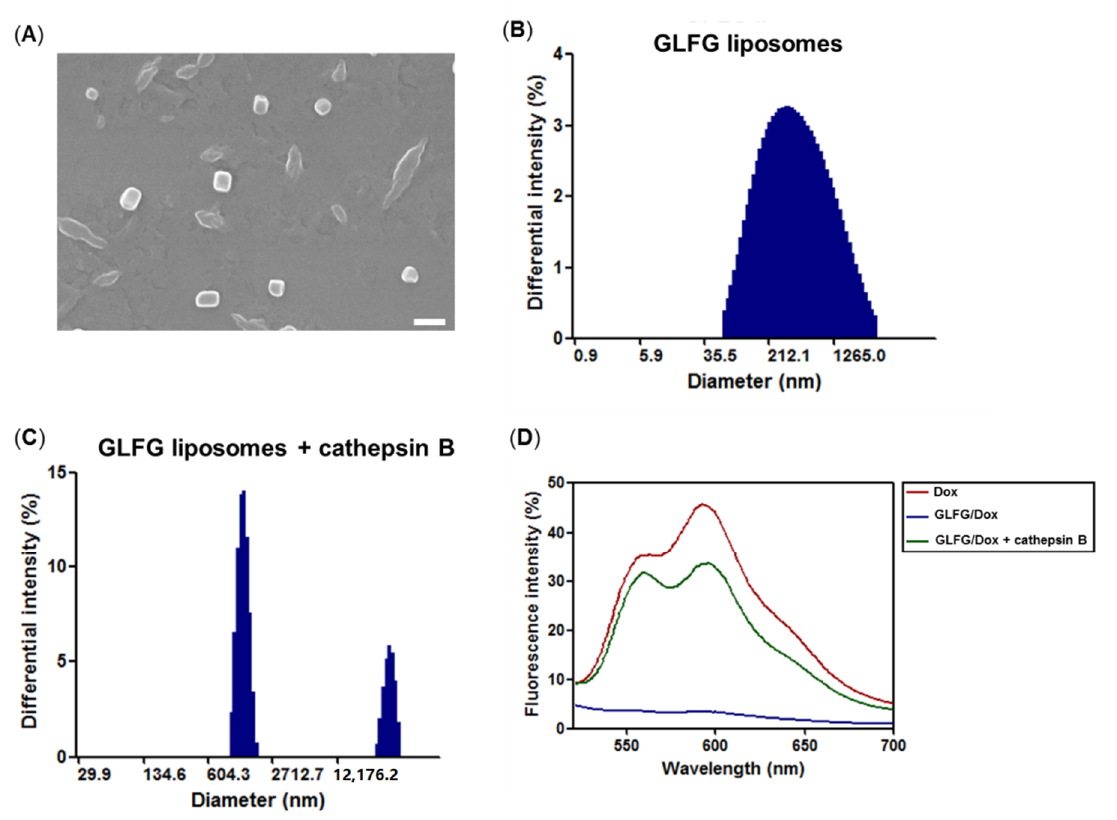
Figure 4. Characterization of GLFG liposomes and GLFG / Dox. ( A ) Morphology of GLFG liposomes by FE-SEM (scale bar = 200 nm), DLS of native GLFG liposomes ( B ), and GLFG liposomes treated with cathepsin B ( C ). ( D ) fluorescence spectroscopy of free Dox, GLFG / Dox, and GLFG / Dox treated with cathepsin B.